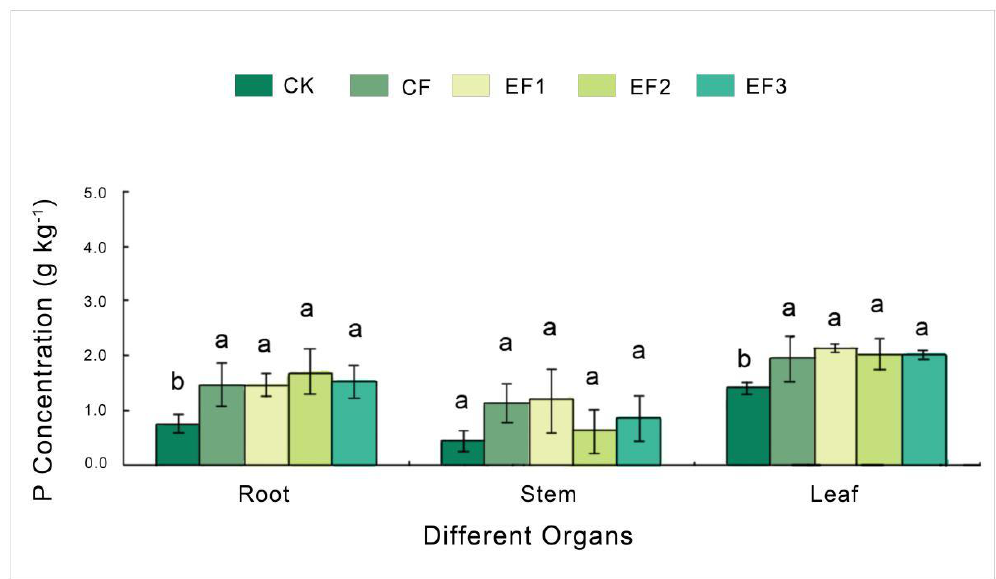
Figure 5. Organ phosphorus (P)-concentration of Chinese fir at different fertilization levels. (Different letters in the same histogram of organs indicate significant difference at 0.05 level).